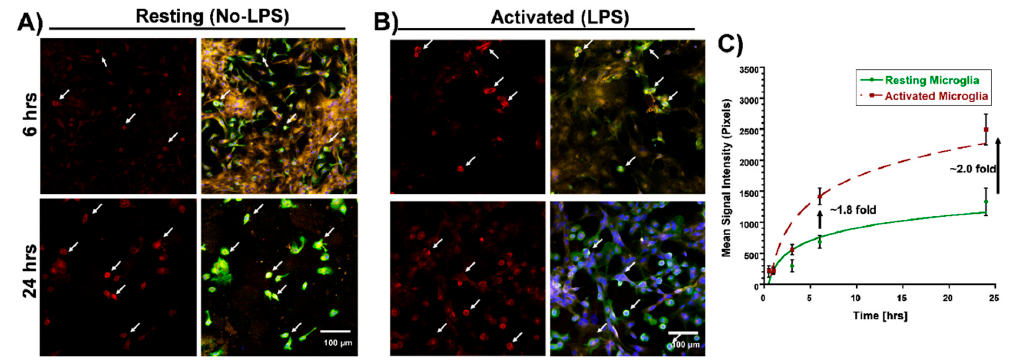
Figure 6. Time-dependent (6 and 24 h) and differential dendrimer uptake between resting and activated microglial cells in mixed glial cultures from neonatal rabbit brain. ( A ) Resting (no-LPS) microglia show time-dependent increase in dendrimer uptake (white arrows). ( B ) Activated (LPS) microglial cells show higher uptake of D-Cy5 (white arrows) compared to resting microglial cells, and this phenomenon is consistent as the time increases. ( C ) Mean signal intensity measurements of intracellular dendrimers (D-Cy5) form confocal images, suggesting relatively higher magnitude of dendrimer (D-Cy5) uptake in activated microglial cells (n = 4). Scale bar 100 μ m.